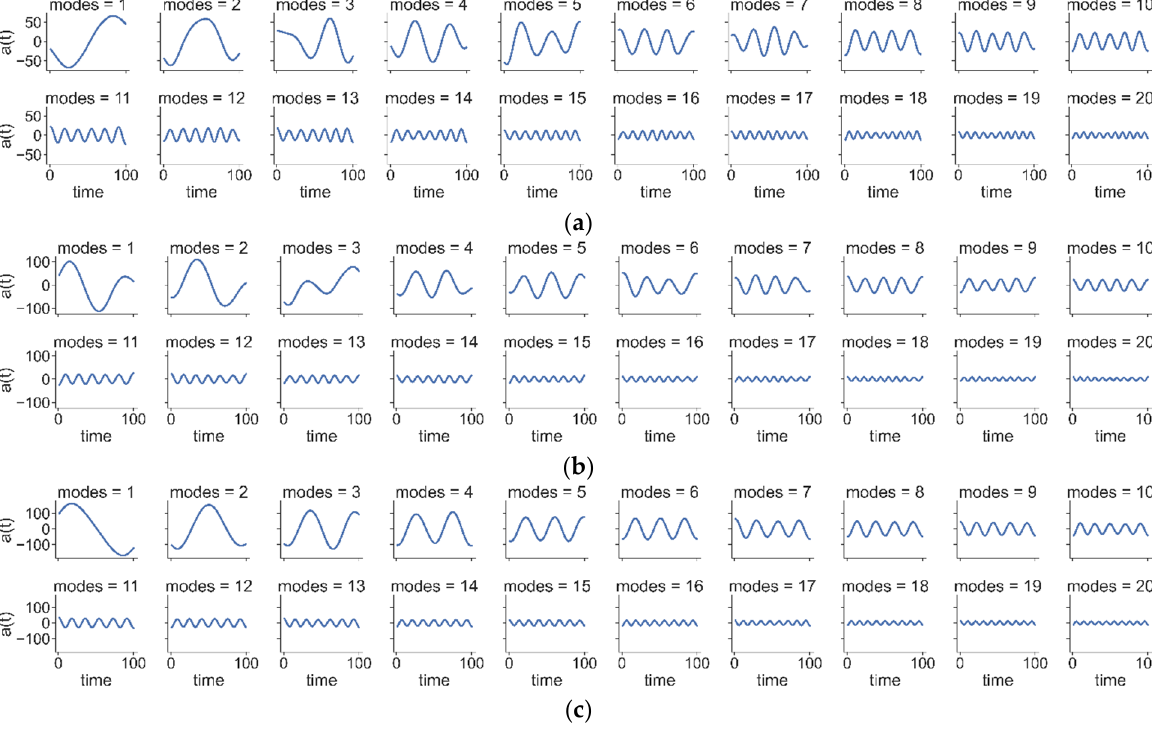
Figure 15. Time coefficients of the first 20 modes in the SWBLI region with ( a ) Ma = 1.5, ( b ) Ma = 2.0, ( c ) Ma = 2.5.